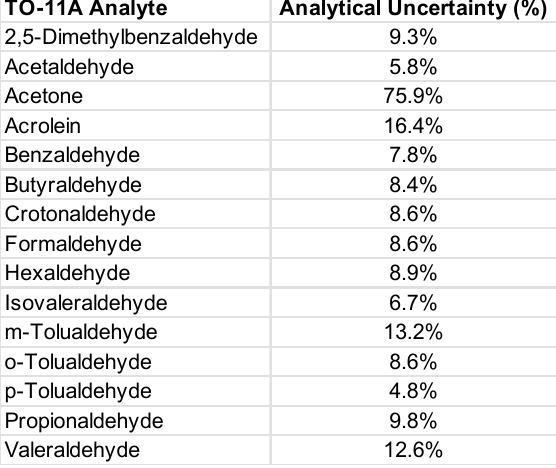
Figure A5. Analytical uncertainties in analytes on the TO-11A list. Table A1. Resulting concentrations and calculated inside/outside (I/O) chamber concentration ratios for TO-15/TO-11A analytes above reporting limits (RL) in at least one air sample from the 4 May 2021 short-term natural condition test. Symbols “likely ↑ ” and “likely ↓ ” denote likely, albeit not directly quantifiable, increases and decrease, respectively.